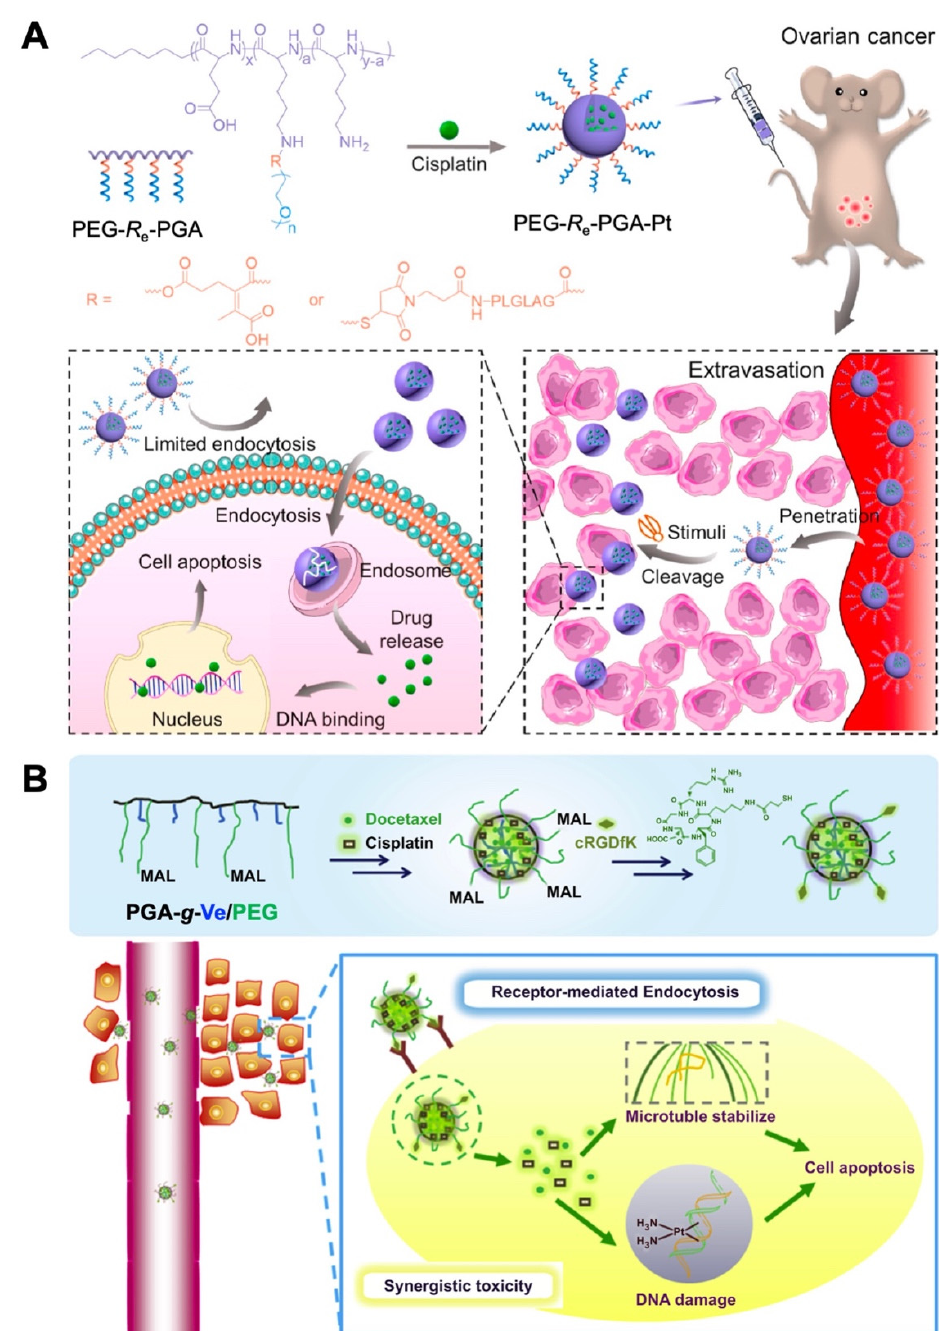
Figure 3. Pt drugs were encapsulated in PGA-based nanomaterials for the treatment of cancer. ( A ) Schematic illustration of PGA-Pt nanocarriers with cleavable PEG response to tumor microenvironments. Reprinted with permission from Ref. [74]. Copyright 2021, Elsevier. ( B ) DTX/CDDP co-encapsulated nanocarriers decorated with the targeting of c(RGDfK) enter tumor tissues by receptor- mediated cellular uptake. Reprinted with permission from Ref. [75]. Copyright 2013, Elsevier.